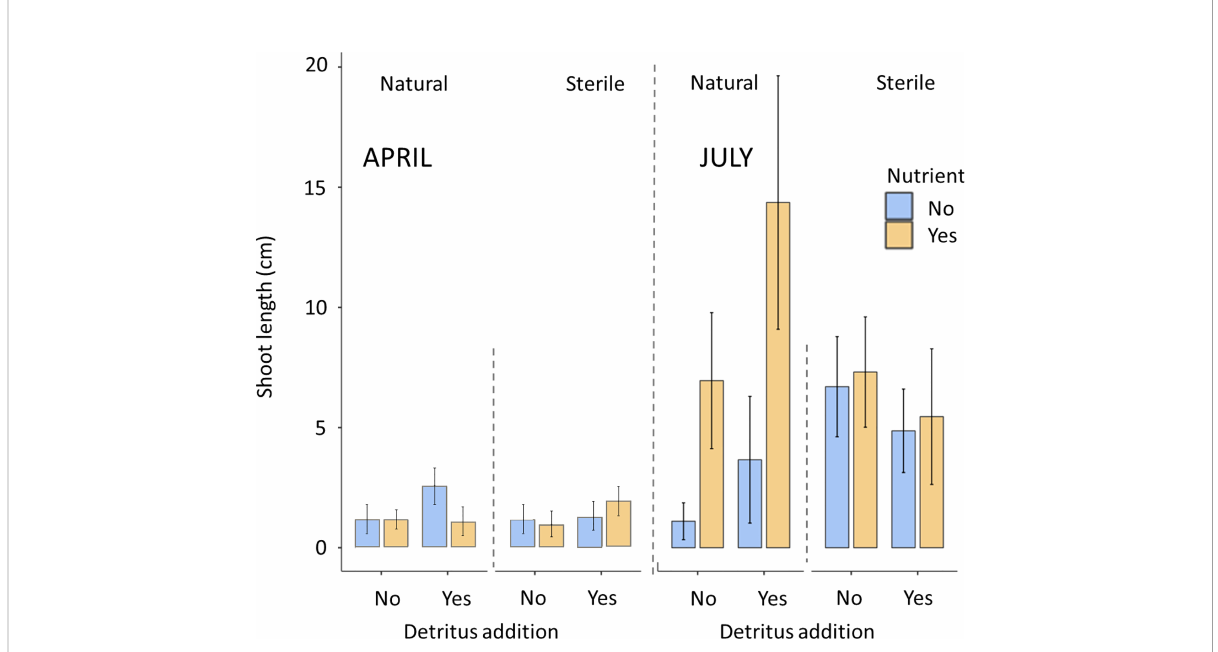
FIGURE 3 Maximum shoot length (mean ± SD) of seagrass ( Zostera marina ) recorded in hessian bags in Dale, Wales following experimental planting. Seagrass seeds were planted into hessian bags according to a factorial design of three treatments (sediment type, detritus addition, nutrient